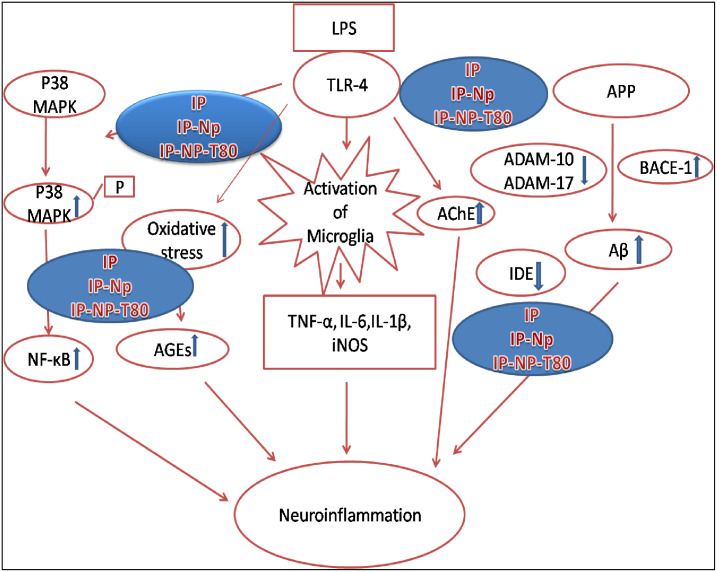
Schematic Diagram for the possible effect of ipriflavone and ipriflavone nanoformulation on LPS brain inflammation induced rats.Ipriflavone (50mg/kg), IP-Np and IP-Np-T80 ameliorated LPS induced brain inflammation in hippocampal region of adult male rats. Neuroprotective effect can be attributed to its anti-inflammatory activity and its ability to decrease the level of pro-inflammatory cytokines and its antioxidant activity.